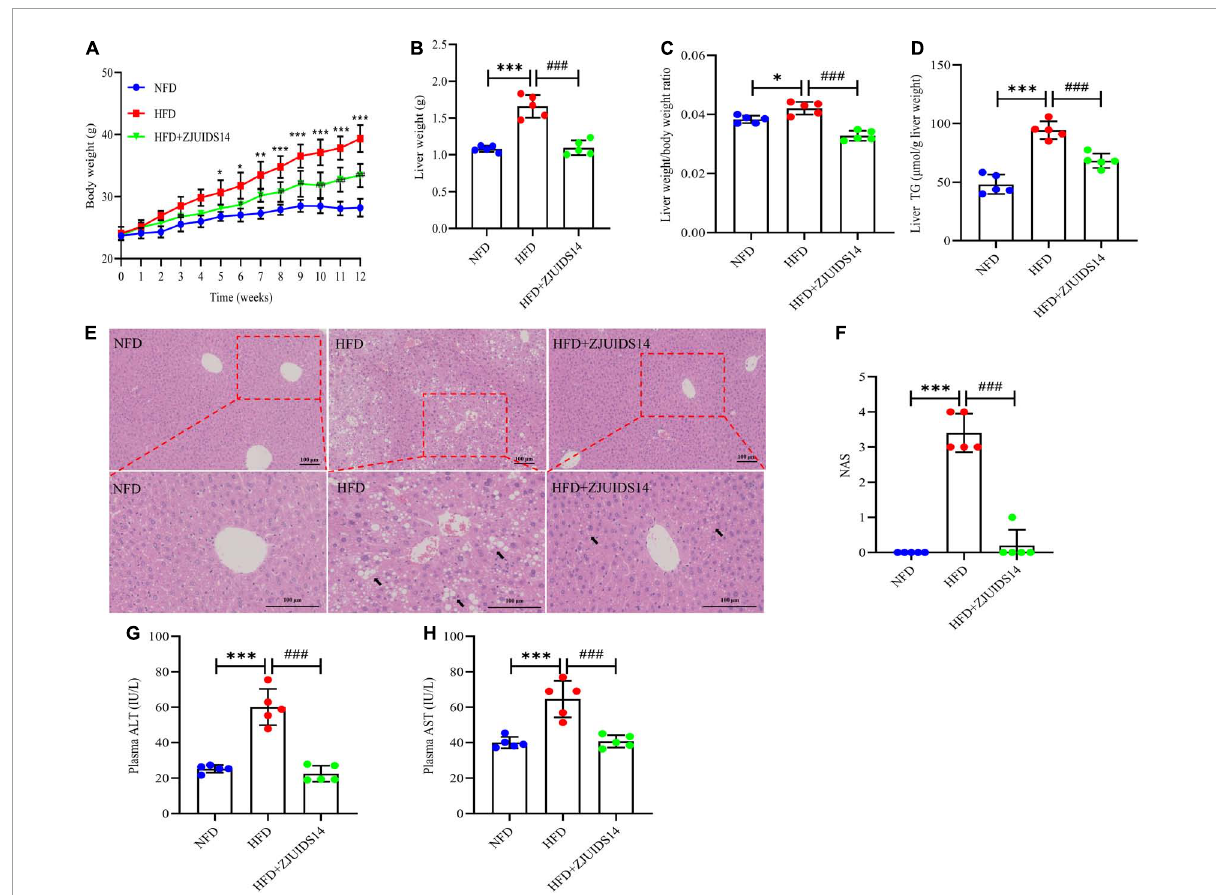
FIGURE1 Lactobacillus plantarum ZJUIDS14 administration ameliorates hepatic steatosis and liver damage in HFD-fed mice. (A) Body weights; (B) liver weights; (C) liver weight/body weight ratio; (D) liver TG; (E) liver H&E staining, magnification. (F) NAFLD activity score (NAS); (G) plasma ALT; (H) plasma AST. ∗ P < 0.05, ∗∗ P < 0.01, ∗∗∗ P < 0.001 vs NFD group; ### P < 0.001 vs HFD